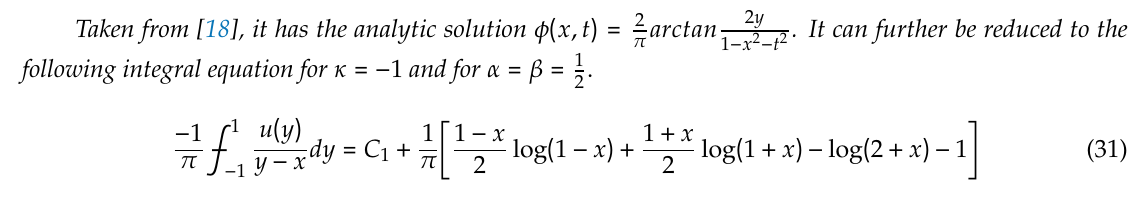
Figure 1. The mixed boundary value